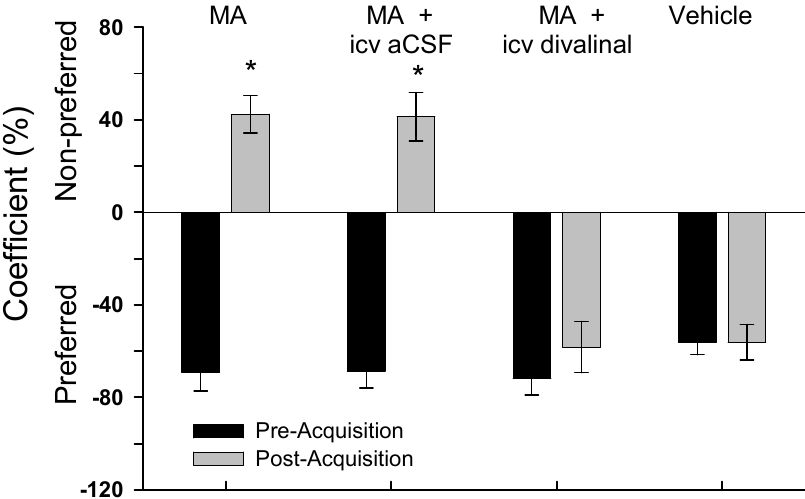
Figure 2. Mean ± SEM percent time spent in the designated compartment (Preferred or Non-preferred) by the four groups in Experiment 1. Following acquisition trials the animals given only MA showed a clear shift from the preferred to the nonpreferred compartment suggesting dependence. This behavioral shift was also seen with those animals injected with MA and icv infused with aCSF via mini-osmotic pumps. Members of the group given MA and icv infused with divalinal failed to show a shift to the nonpreferred compartment suggesting no dependence. As expected those animals given vehicle (s.c.) continued to stay in the preferred compartment. * p <